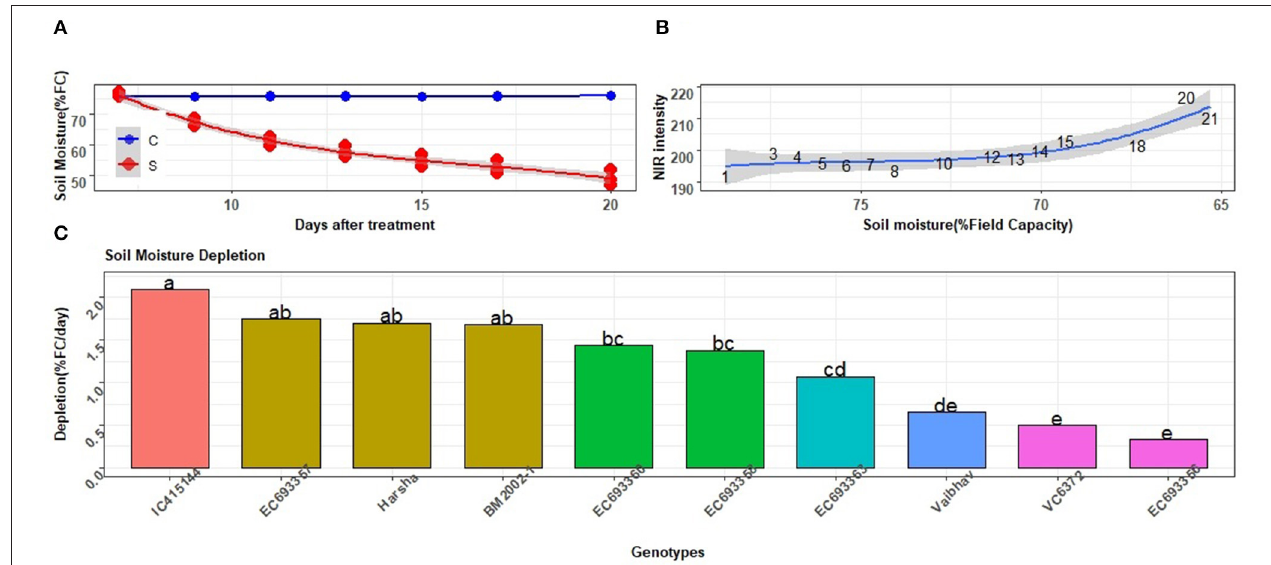
FIGURE 10 | Responses of the selected mungbean genotypes to depleting soil moisture. (A) Level of soil moisture as indicted by % field capacity (FC) in well-watered (c) and water-stressed (s) plants. Solid lines represent mean values for all genotypes in each of the treatments. (B) Tissue water content in response to the depletion of soil moisture as indicated by NIR signals. High and low NIR values indicated more and less tissue water content, respectively. Values indicated along the curve represent days after withdrawal of water application to pots. (C) Rate of depletion of soil moisture in different mungbean genotypes; each value is an average of three replications of water-stressed plants. Letters represent the significance of differences among the mean values as computed by the Duncan multiple range test at 0.95 CI. Genotypes with common letters are not significantly